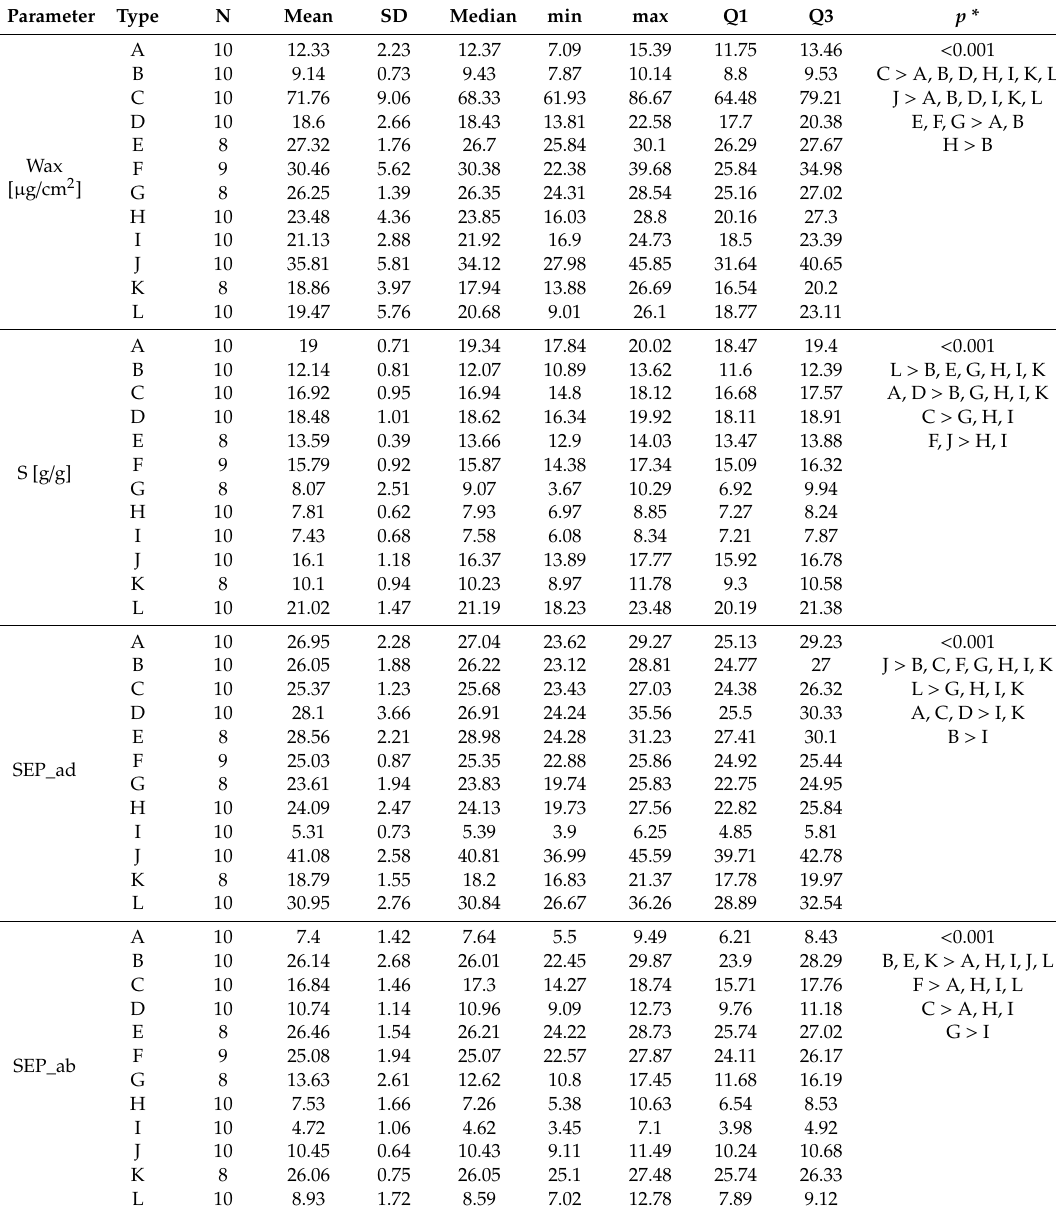
Table 3. The Kruskal-Wallis test and post-hoc analysis (Dunn’s test) to determine the interrelationships between the analysed